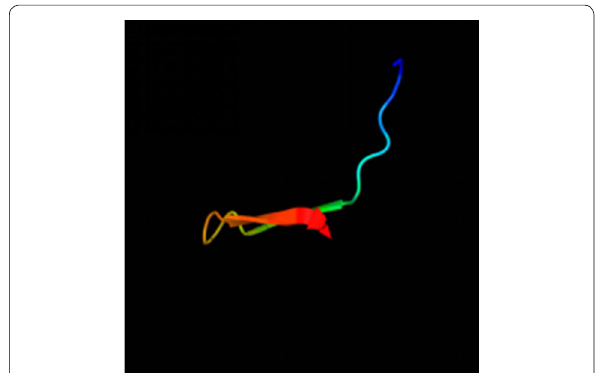
Fig. 1 Phyre 2 predicted tertiary structure of the hybrid peptide (arrow from N C)